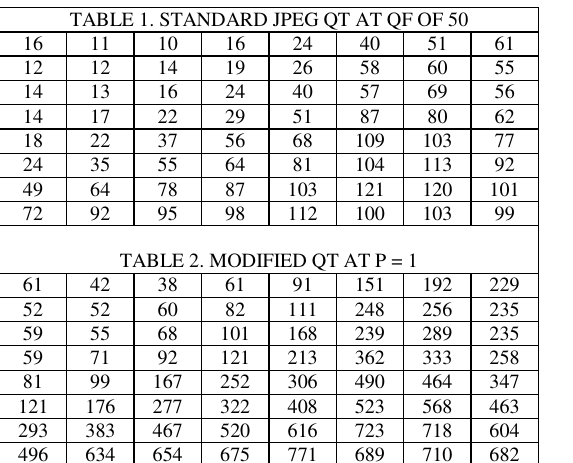
TABLE 2. MODIFIED QT AT P = 1